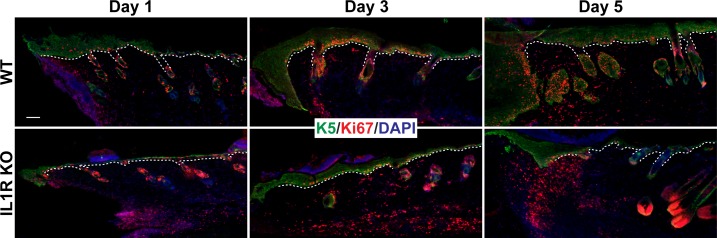
Representative image of Figure 1C.Skin sections from 8-week-old WT and IL1R KO mice were stained for keratin 5 (K5) (green), Ki67 (red) and DAPI (blue), for 1, 3, and 5 days postwounding. White dotted lines represent the basement membrane that separates the epidermis from the underlying dermis. Scale bar = 50 μm.